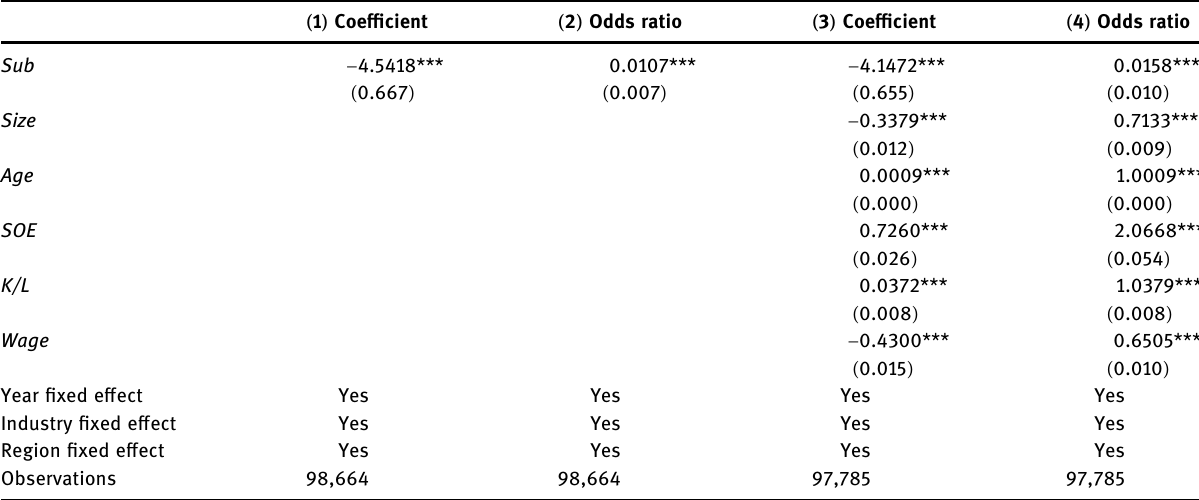
Table 3: Impact of fi scal subsidies on zombie fi rms ’ death probability